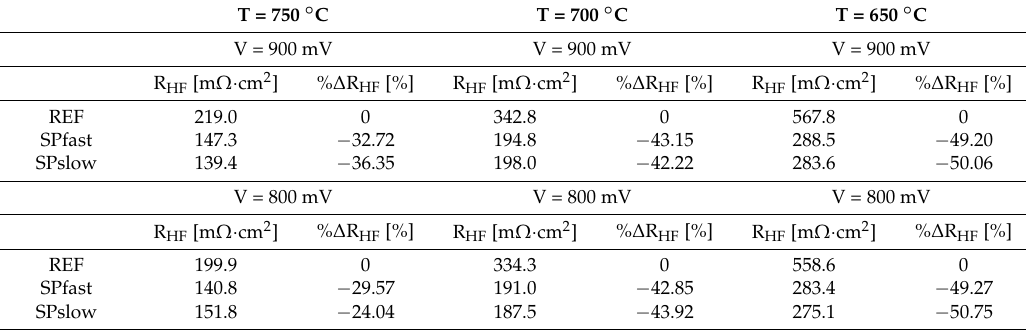
Table 3. Measured values of the high frequency resistance R HF for the tested samples.